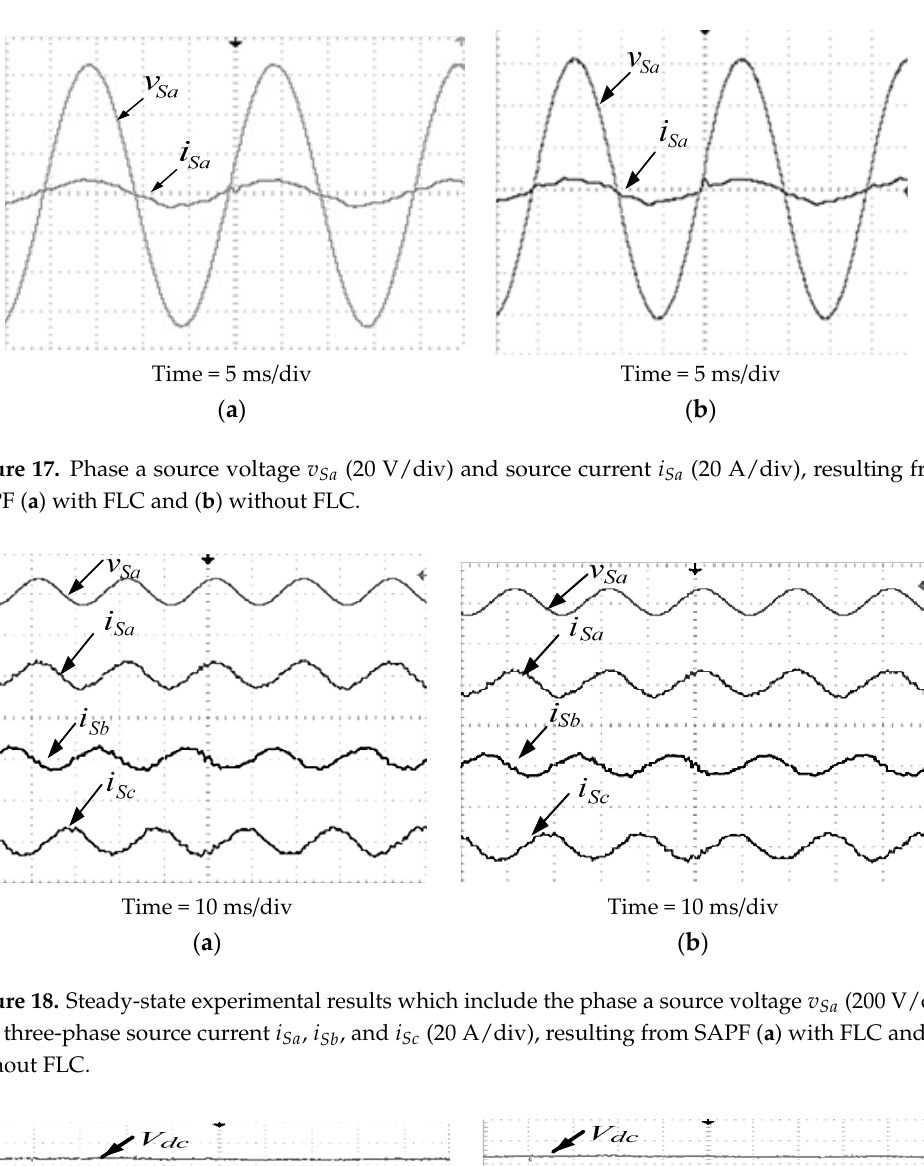
Figure 16. Steady-state experimental result showing the phase a source voltage (cid:1874) (cid:3020)(cid:3028) (200 V/div), source current (cid:1861) (cid:3020)(cid:3028) (20 A/div), load current (cid:1861) (cid:3013)(cid:3028) (10 A/div), and compensation current (cid:1861) (cid:3004)(cid:3028) (10 A/div) , resulting from SAPF ( a ) with FLC and ( b ) without FLC.